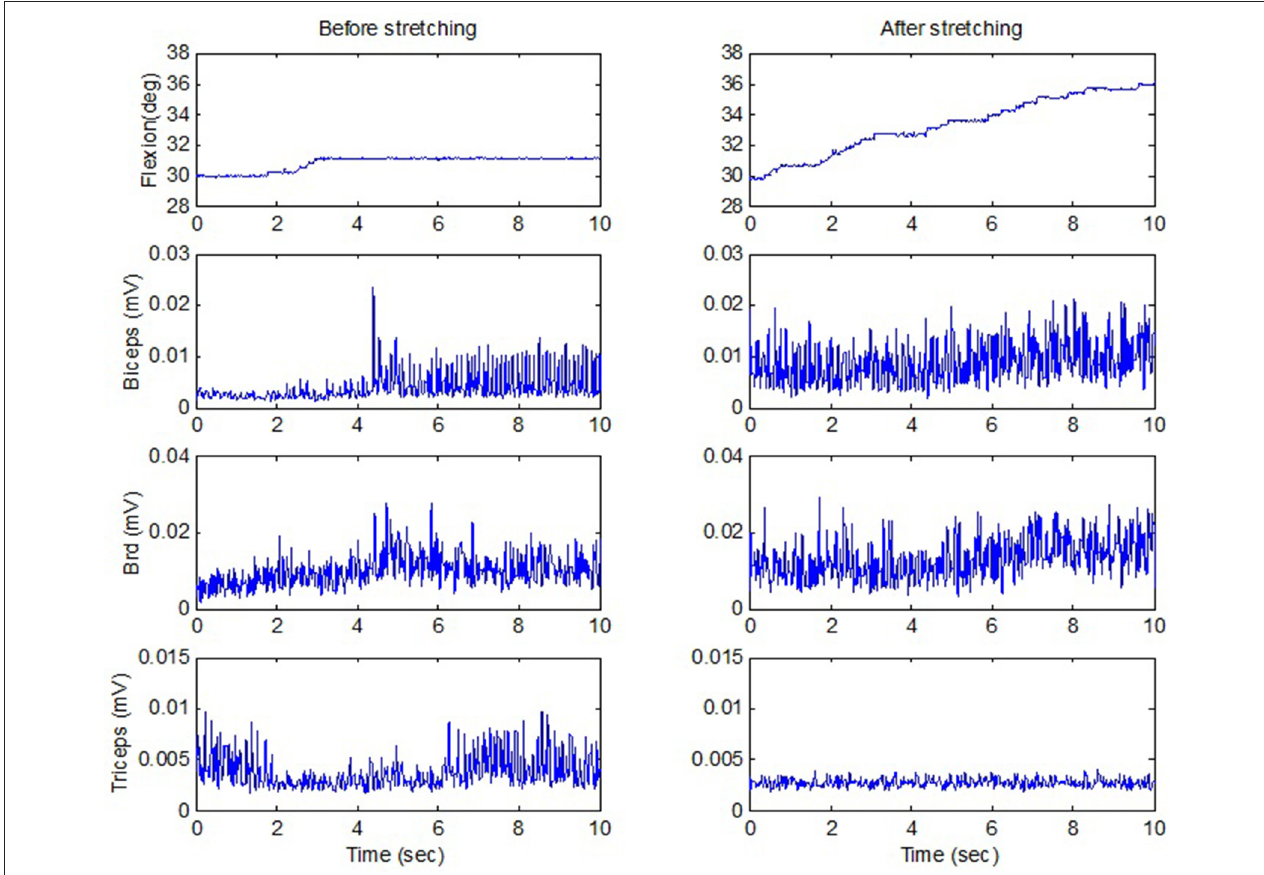
FIGURE 6 | Active ROM when a stroke survivor moved against the passive load of the stretching device including a motor and gearhead (the motor was switched off), before and after stretching. The upward flexion movement was in the vertical plane against gravity. There was considerable reduction of triceps co-contraction (the last row) after stretching, with even stronger biceps contraction. deg, degrees; mV, millivolts; sec,